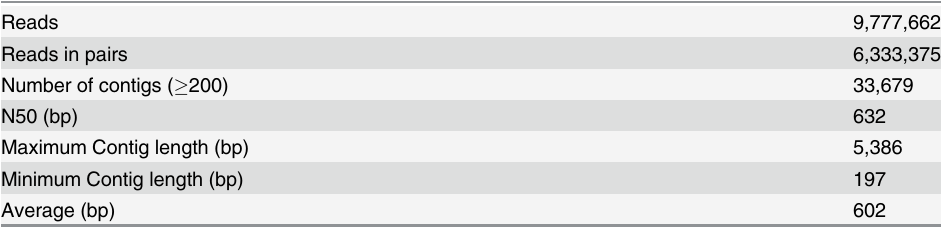
Table 1. Assembling